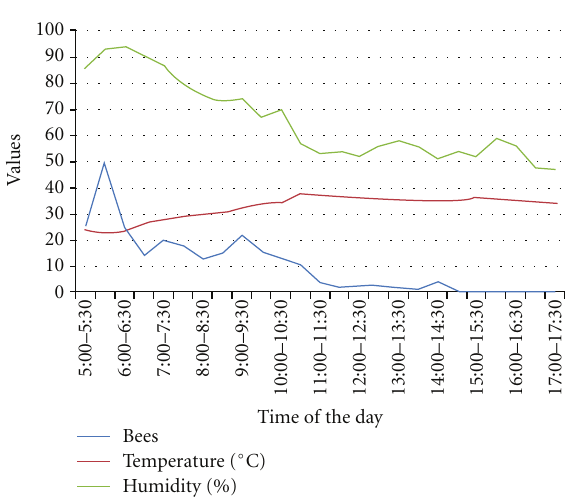
Figure 1: Frequency of floral visitors associated to temperature and relative humidity (at each 30 minutes) in a commercial cultivation of Brazil nut ( Bertholletia excelsa ) in the county of Itacoatiara, state of Amazonas, Brazil,